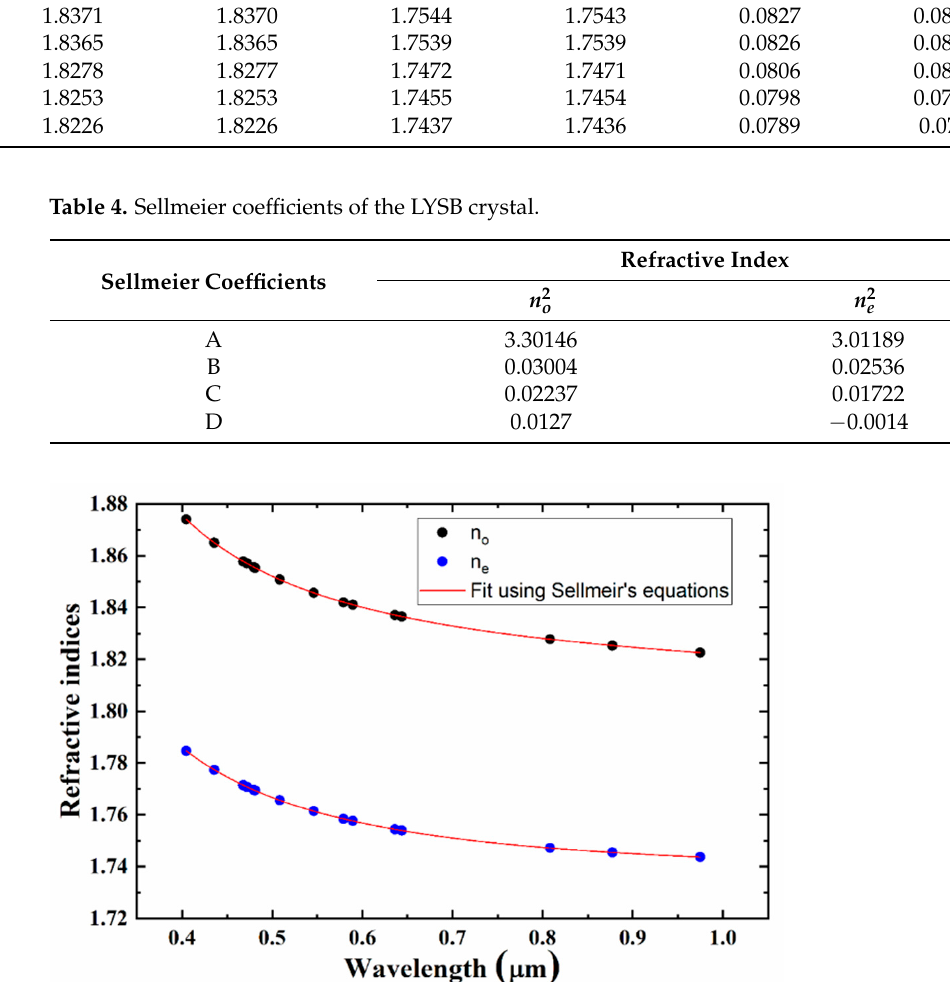
Figure 13. Variation of refractive indices with wavelength in the LYSB crystal. (Reprinted with permission from ref. [13], copyright 2019 American Chemical Society).